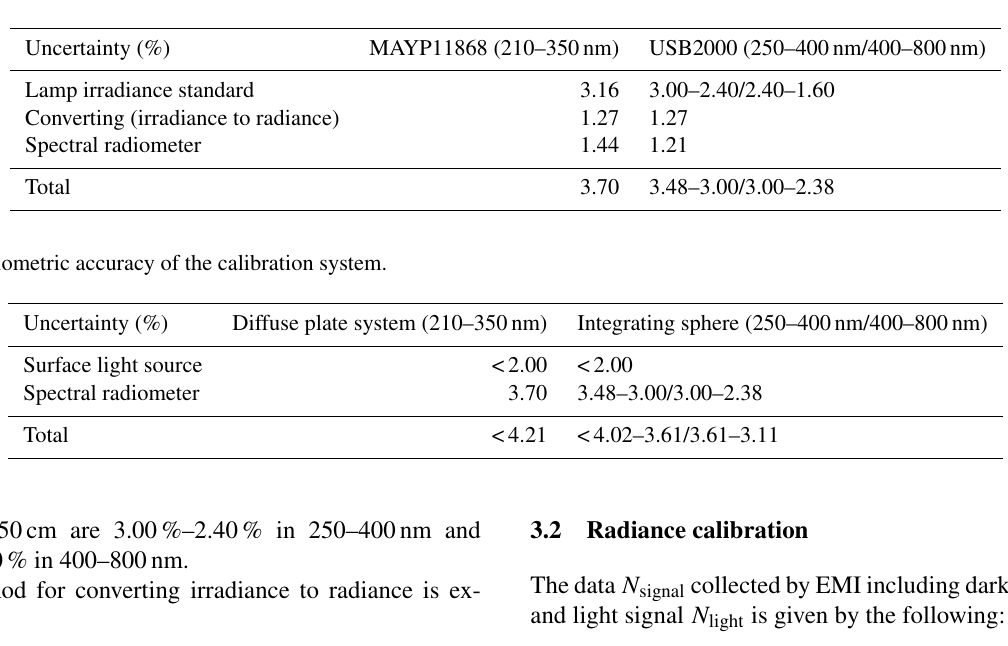
Table 6. Calibrated accuracy of the spectral radiometer.